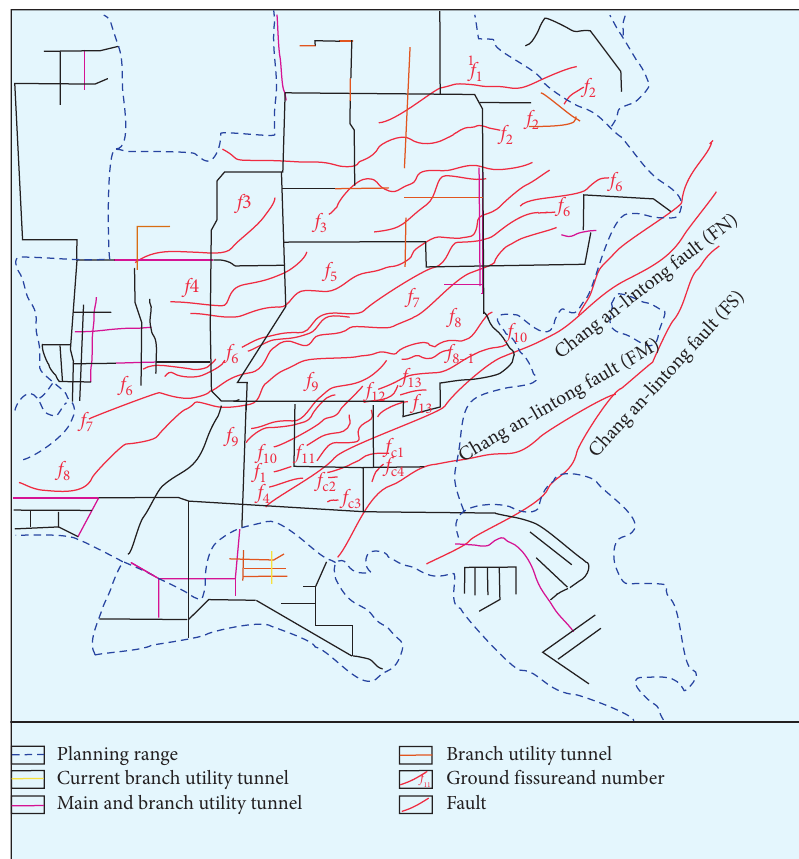
Figure 1: Xi’an underground utility tunnel and ground fissure